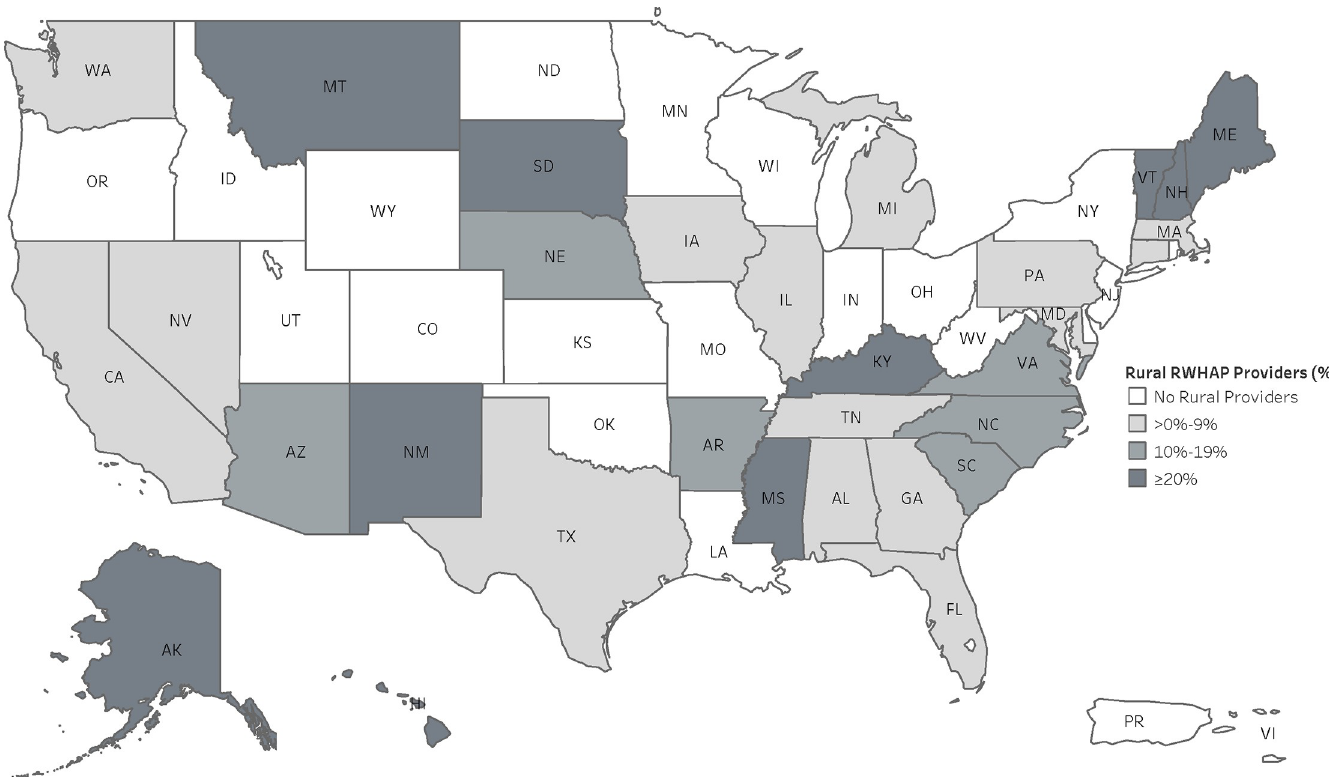
Fig 1. Percent of HRSA RWHAP providers in rural areas, by state, 2017. This figure displays the percentage of RWHAP providers within each jurisdiction that were located in rural-designated areas. The number and percentage of rural providers for all jurisdictions are available in S1 Table.